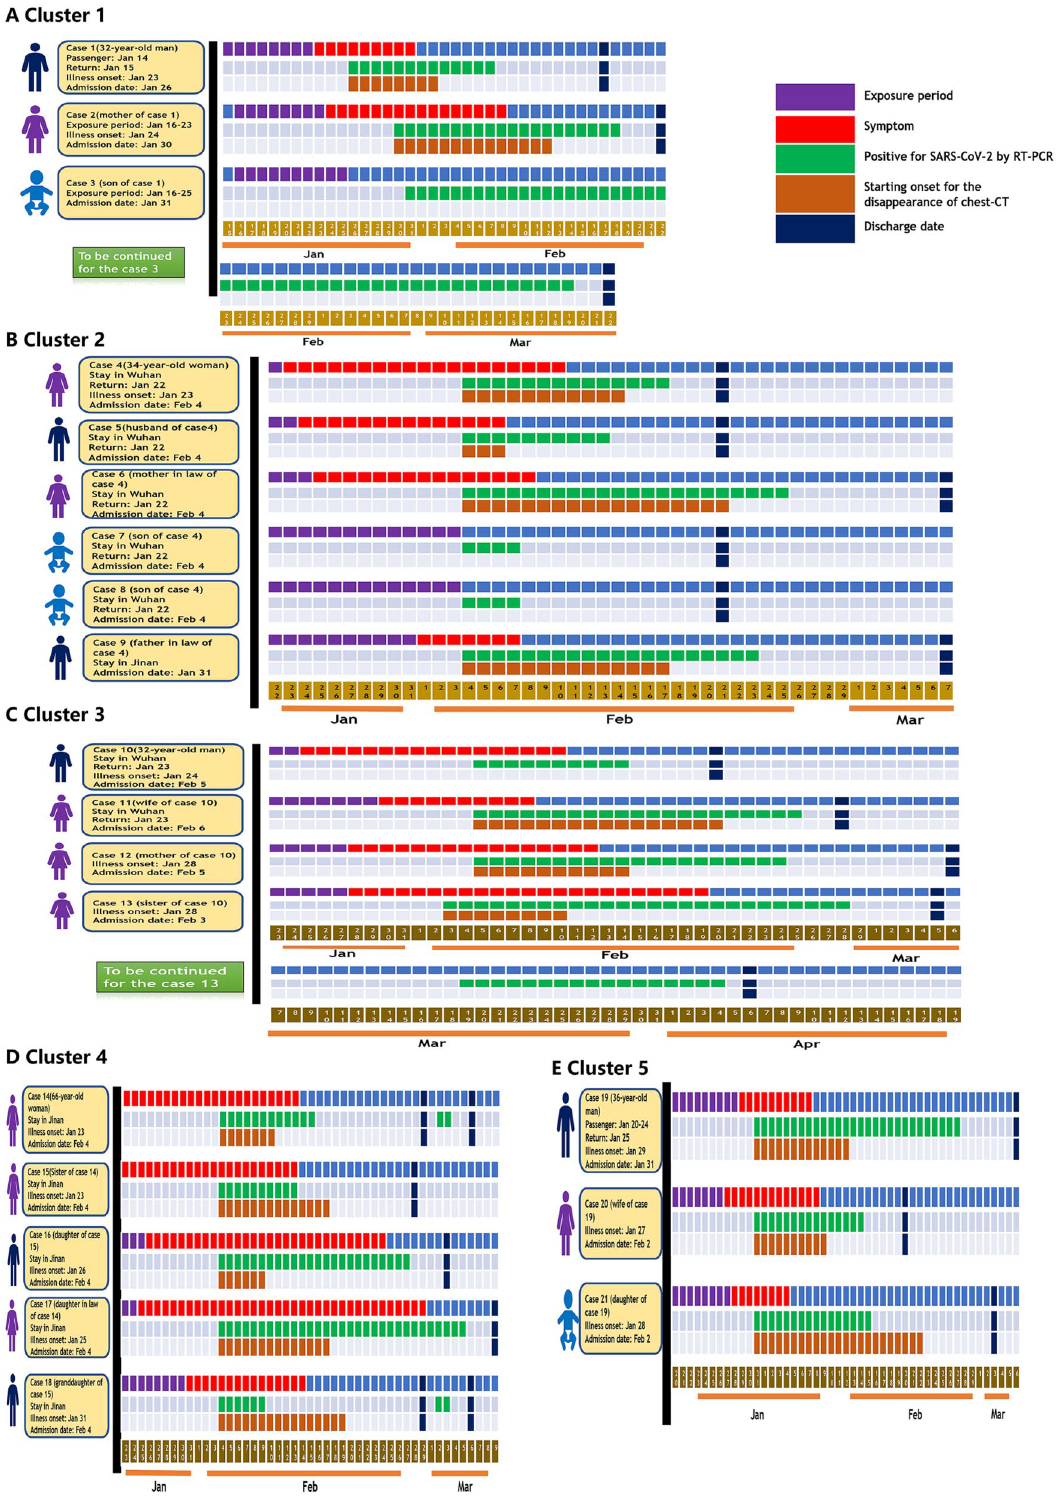
Figure 1. The timelines for all the 21 patients with COVID-19 from all the five family